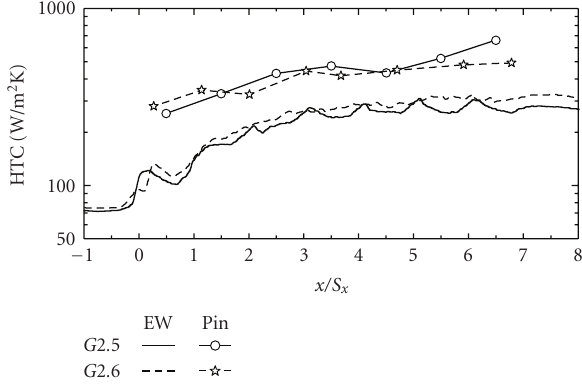
Figure 11: G 2.5 and G 2.6 endwall spanwise averaged and pin fin HTC—Re d 7 =